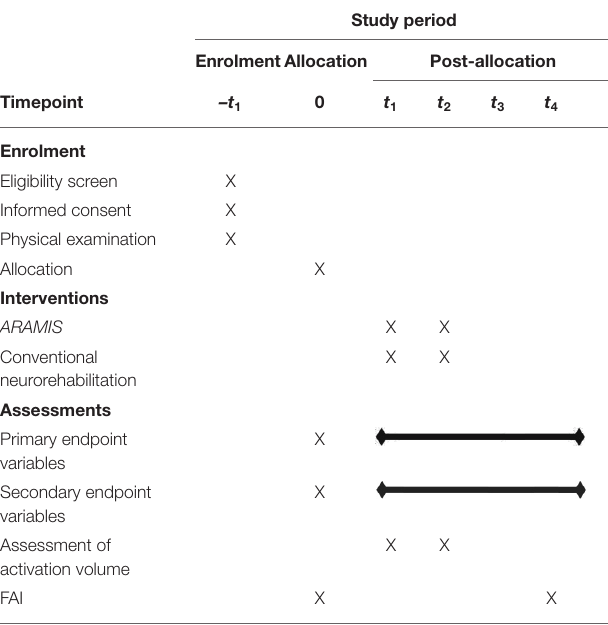
TABLE 1 | Schedule of enrollment, interventions and assessments according to Standard Protocol Items: Recommendations for Interventional Trials (SPIRIT). Study